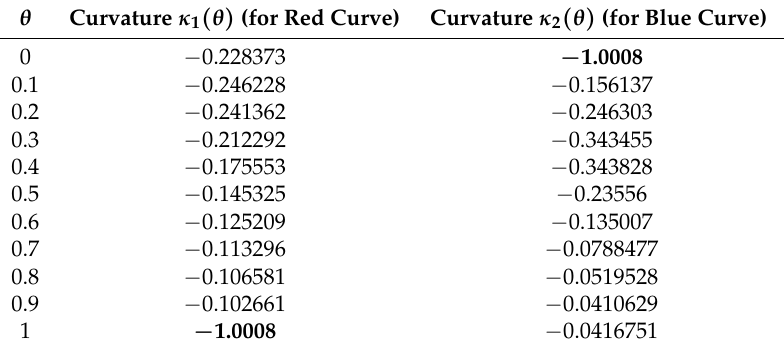
Curvatures of Classical Bezier curves (Thick lines)) Curvatures of GHT-Bezier curves (Dashed lines) ( b ) Comparison of the curvature between the GHT-Bézier curve and classical Bézier curve Figure 12. Graphical representation of the G 2 continuity for the GHT-Bézier curve and the classical Bézier curve. ( a ) G 2 continuity between two cubic GHT-Bézier curve segments; ( b ) comparison of the curvature between the GHT-Bézier curve and classical Bézier curve. Table 2. Curvature values for G 2 continuity by the GHT-Bézier curve.